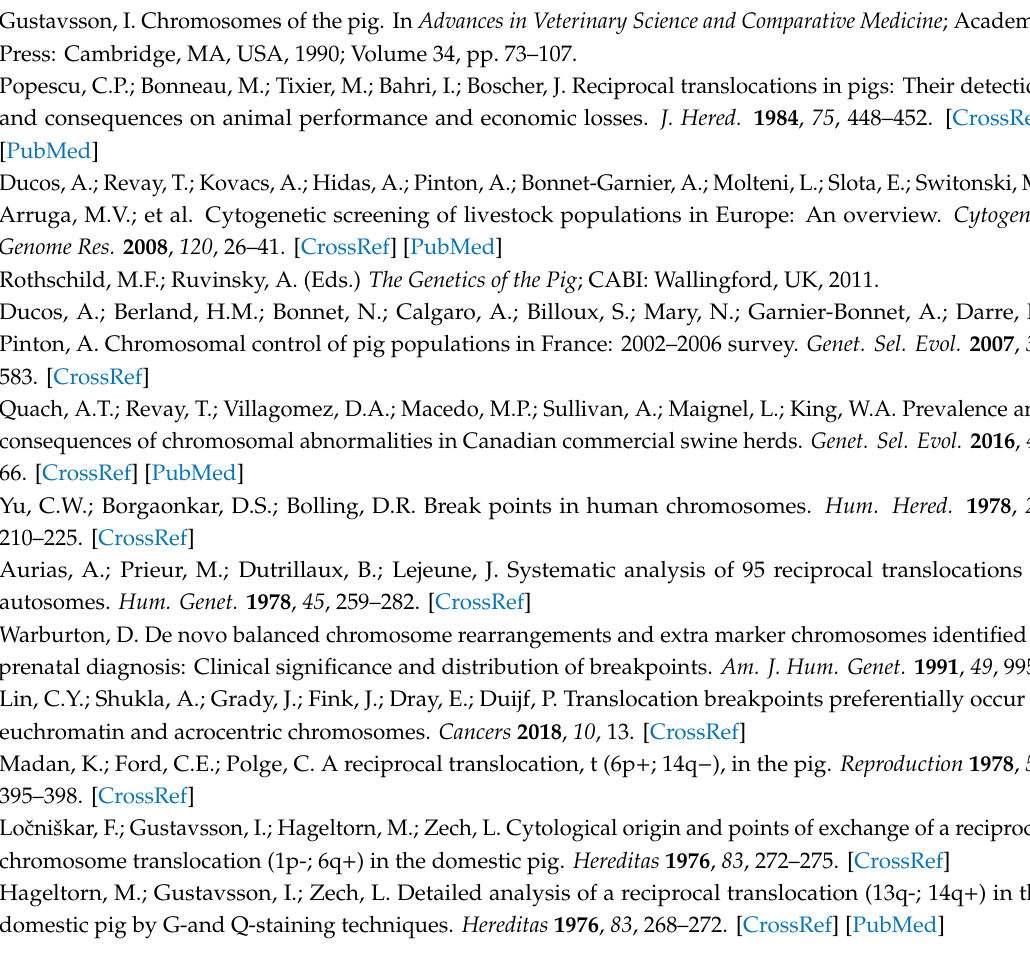
Table S1:List of Chromosome Rearrangements in the Pig Genome, Figure S1: Standard Karyotype of the Domestic Pig, Table S2: Estimated Physical Length of Porcine Cytogenetic Bands, Table S3: Verification of Estimated Cytogenetic Band Lengths using BAC Clones, Table S4: List of Common Fragile Sites in the Pig